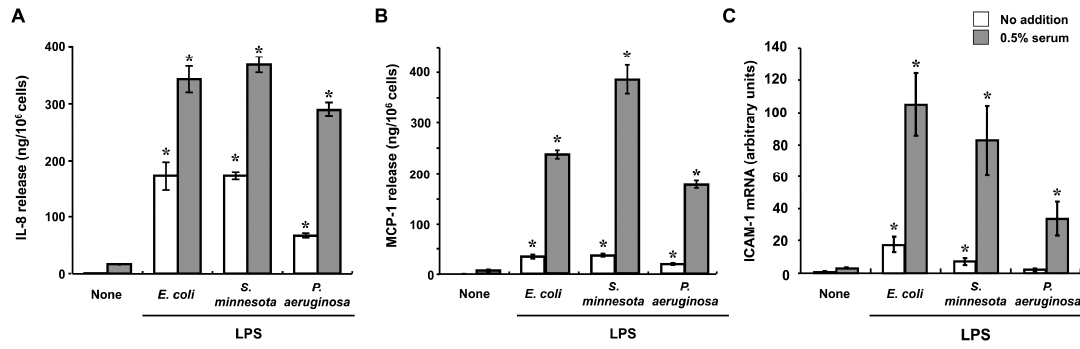
Figure 1. Effects of lipopolysaccharide (LPS) on chemokine release and the abundance of ICAM-1 mRNA in human corneal fibroblasts. Cells were incubated for 24 h ( A , B ) or 6 h ( C ) with or without LPS (10 ng/mL) from Escherichia coli ( E. coli ), Salmonella minnesota ( S. minnesota ), or Pseudomonas aeruginosa ( P. aeruginosa ) as well as in the absence (open bars) or presence (closed bars) of 0.5% human serum. The amounts of IL-8 ( A ) and MCP-1 ( B ) released into the culture medium were then determined by enzyme-linked immunosorbent assays, and the amount of ICAM-1 mRNA in the cells ( C ) was determined by reverse transcription and real-time polymerase chain reaction analysis. Data are means ± standard error of the mean (SEM) of quadruplicates from representative experiments. * p < 0.05 versus the corresponding value for cells incubated in the absence of LPS. Reprinted with permission from [19].